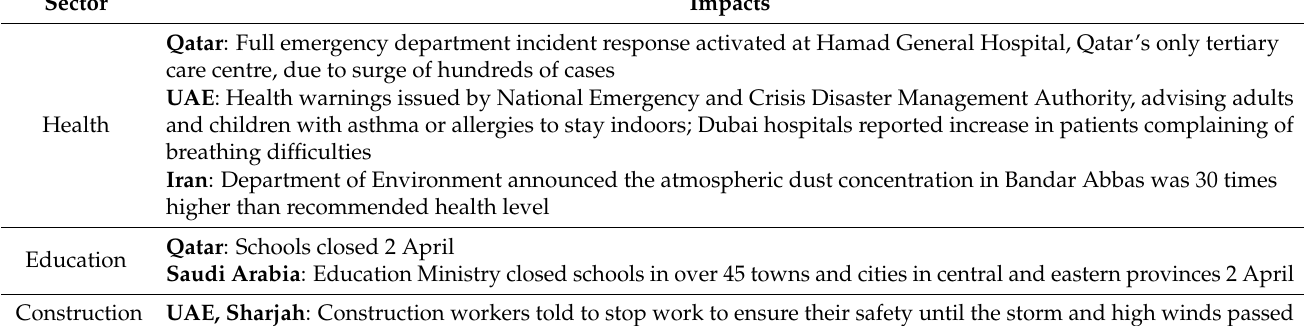
Table 1. Socio-economic impacts of Middle East dust storm event, 1–3 April 2015.